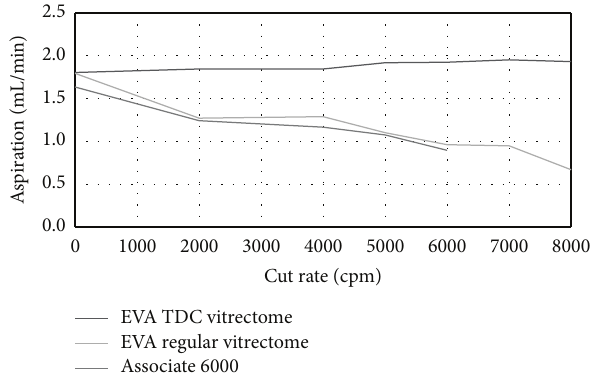
Figure 2: Aspiration flow rates of 25G TDC and standard vitrec- tomes @ 350–550 mmHg.